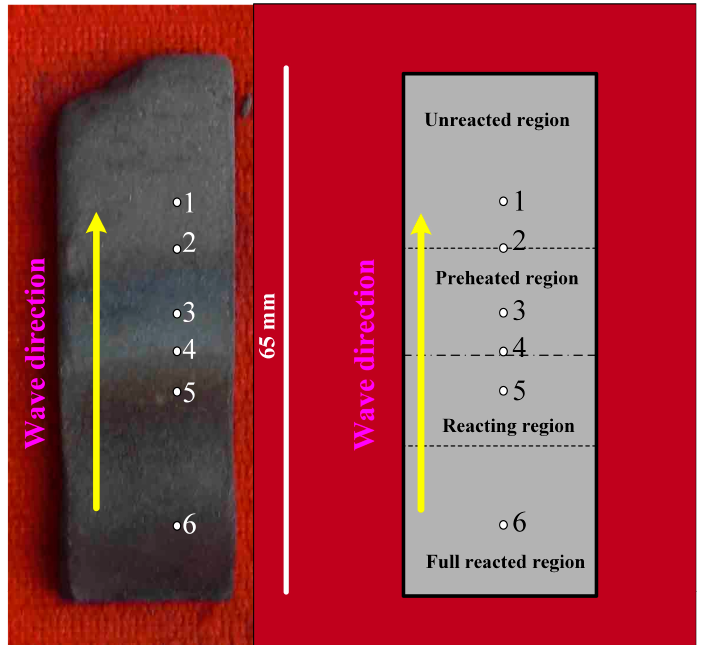
Figure 9. Macroscopic morphology and partition diagram showing different regions of the SHS quenched bar.